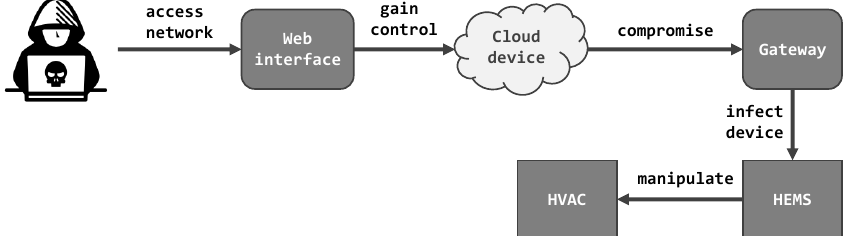
Figure 4. Attack scenario for hijacking of heating and the HVAC